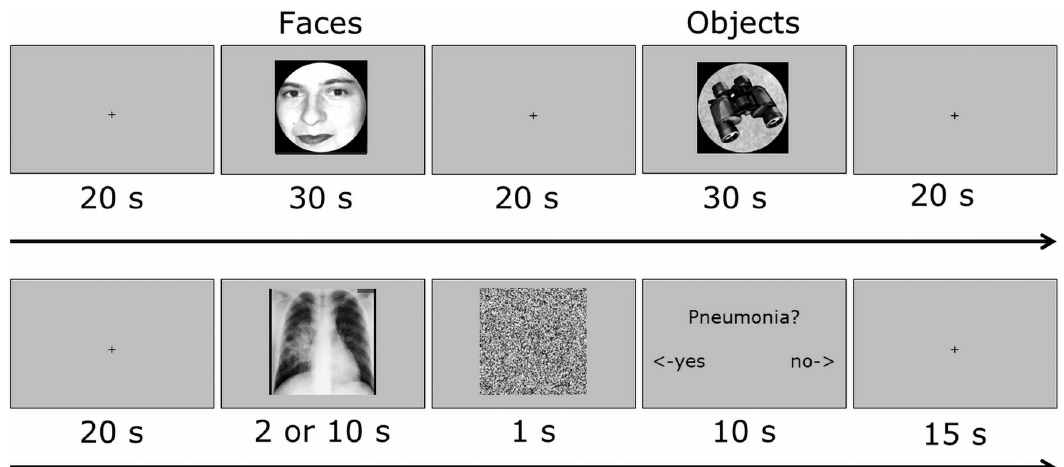
Fig 1. Overview of the experimental designs of the FFA-localization and the diagnostic-reasoning runs. In all runs, the stimuli were presented against a grey background. (A) The FFA-localization procedure used a blocked design in which 45 images of faces and 45 images of objects were shown in blocks of 30s. Between each block, there was a 20s baseline. (B) The diagnostic-reasoning trials consisted of the presentation of the radiograph (2s in short-presentation runs and 10s in long-presentation runs), a scrambled version of this image (mask) presented immediately after for 1s and then the diagnostic question with answer options for 10s. Between trials, there was a 15s baseline period.